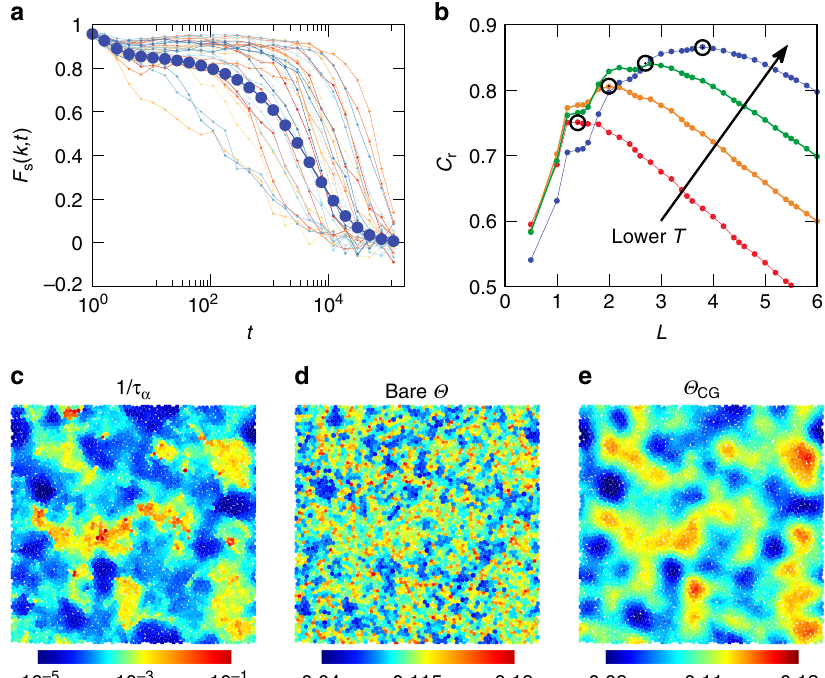
Fig. 3 Nonlocal scenario for structure relaxation at a particle level. a Self-intermediate scattering function F s ð k ; t Þ of each particle (background data) and the whole system (dark blue circles) for a 2D PM ( Δ ¼ 13 % ) at T ¼ 0 : 0018. b Correlation between microscopic relaxation time ( τ α for each particle, see text for its de fi nition) and structural order as functions of coarse graining length L . As indicated by the arrow, different curves correspond to decreasing temperatures, T ¼ 0 : 0037, 0 : 0028, 0 : 0023, and 0 : 0018. The peak positions are indicated by black circles. c – e For the same state point as panel a, typical snapshots of inverse of microscopic relaxation time 1 = τ α (panel c ), bare structural order Θ (panel d ), and structural order Θ (panel e ), where C r shows a peak in panel b